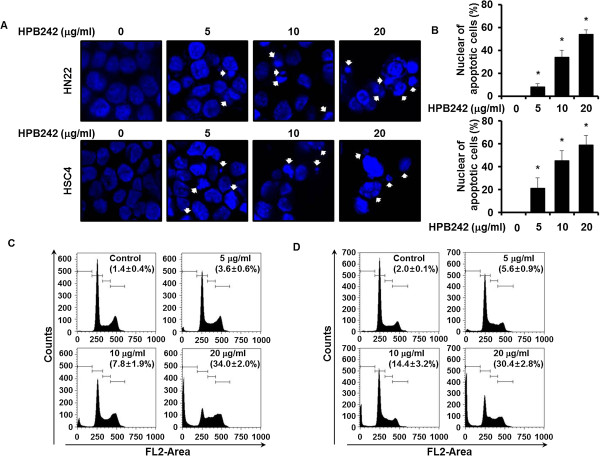
The apoptotic effect induced by HPB242 in HN22 and HSC4 cells. Cells were incubated with HPB242 (5, 10, and 20 μg/ml) and untreated for 48 hours. The cells were harvested and prepared for DAPI staining and PI staining as described in the Methods section. (A) Analysis of DNA fragmentation and nuclear condensation by fluorescence microscopy (magnification ×600) after HPB242 treatment in HN22 and HSC4 cells. (B) DNA fragmentation and nuclear condensation were quantified, and the results in triplicate are expressed as the mean ± SD. (C and D) Representative histograms of Sub-G1 population. HPB242-treated cells were compared with untreated cells, and data are shown as the average of triplicate samples from three independent experiments. The asterisks (*) indicates p < 0.05 versus control cells.